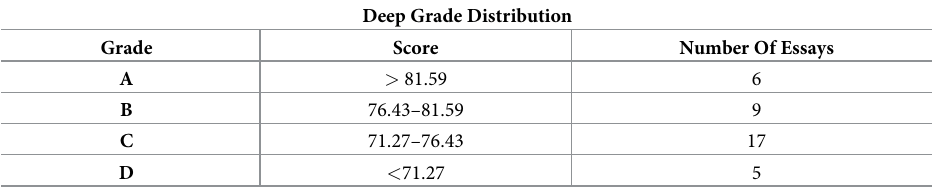
Table 1. Score distributions of student